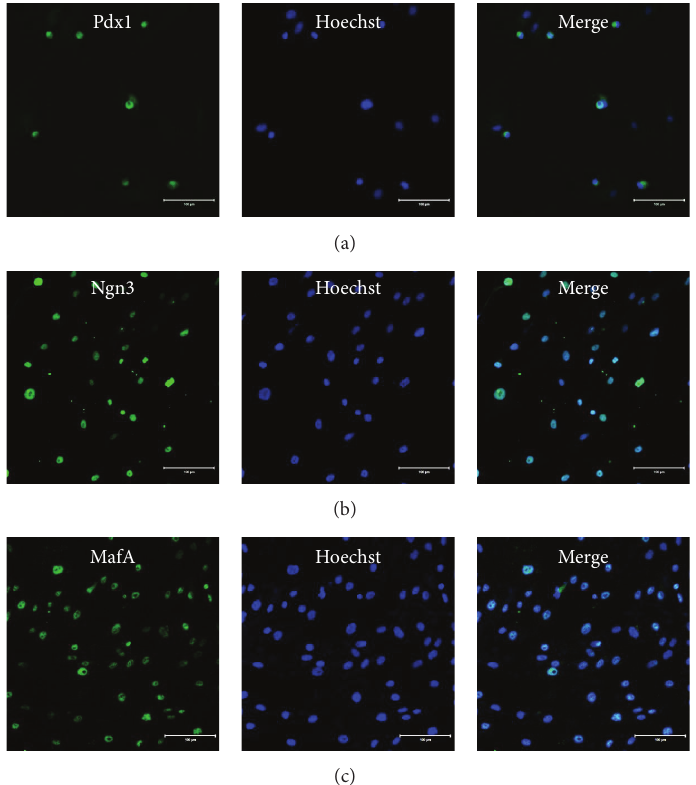
Figure 4: Key pancreatic transcription factors expressed in hpMSCs. Pdx1, Ngn3, and MafA are key transcription factors involved in pancreas development and pancreas progenitor-cell differentiation into 𝛽 -cells. (a) Pdx1-, (b) Ngn3-, and (c) MafA-positive immunofluorescence staining results in the nucleus of hpMSCs during passage 6. Scale bar = 100 𝜇